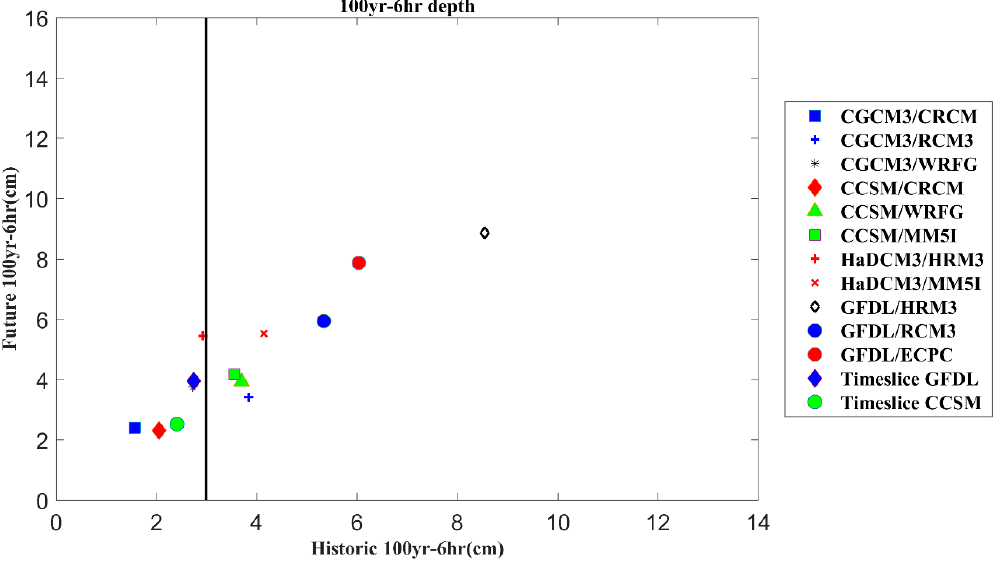
Figure 2. Historic vs future depths (100yr-6hr) of the NARCCAP climate models. The vertical line represents the NARR historical 100yr-6hr depth.